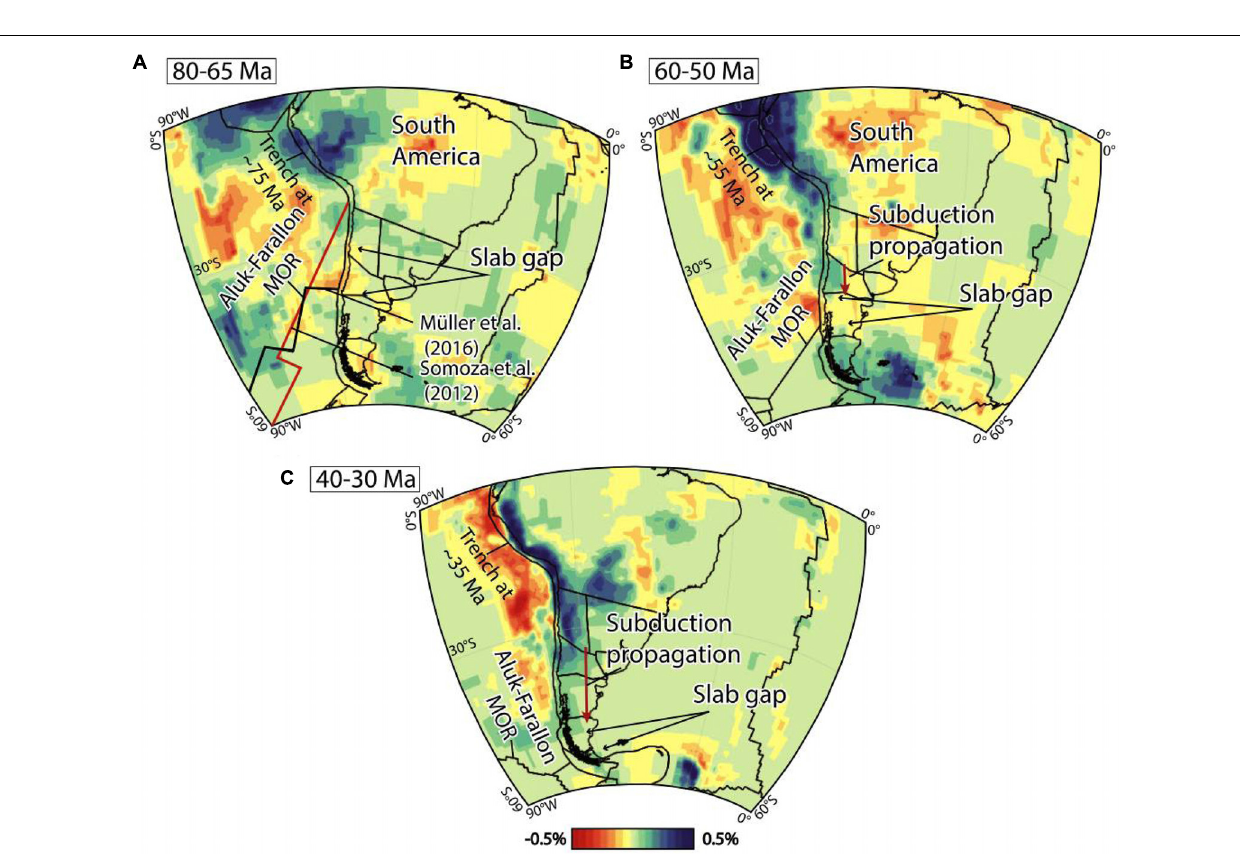
FIGURE 10 | Tomography slices at a depth of (A) 1200 km, (B) 850 km, and (C) 450 km from the UU-P07 global P-wave seismic tomography model (Amaru, 2007). These depths represent three stages of Andean subduction where the preserved mantle structure would correspond to the fossil record of subduction in Late Cretaceous ( ∼ 80–65 Ma), Paleocene–Eocene (60–50 Ma), and late Eocene–Oligocene times (40–30 Ma), respectively. This image shows a striking coincidence between the southward migrations of a slab gap inferred from a discontinuity in fast anomalies below the Andean margin and the inferred position of